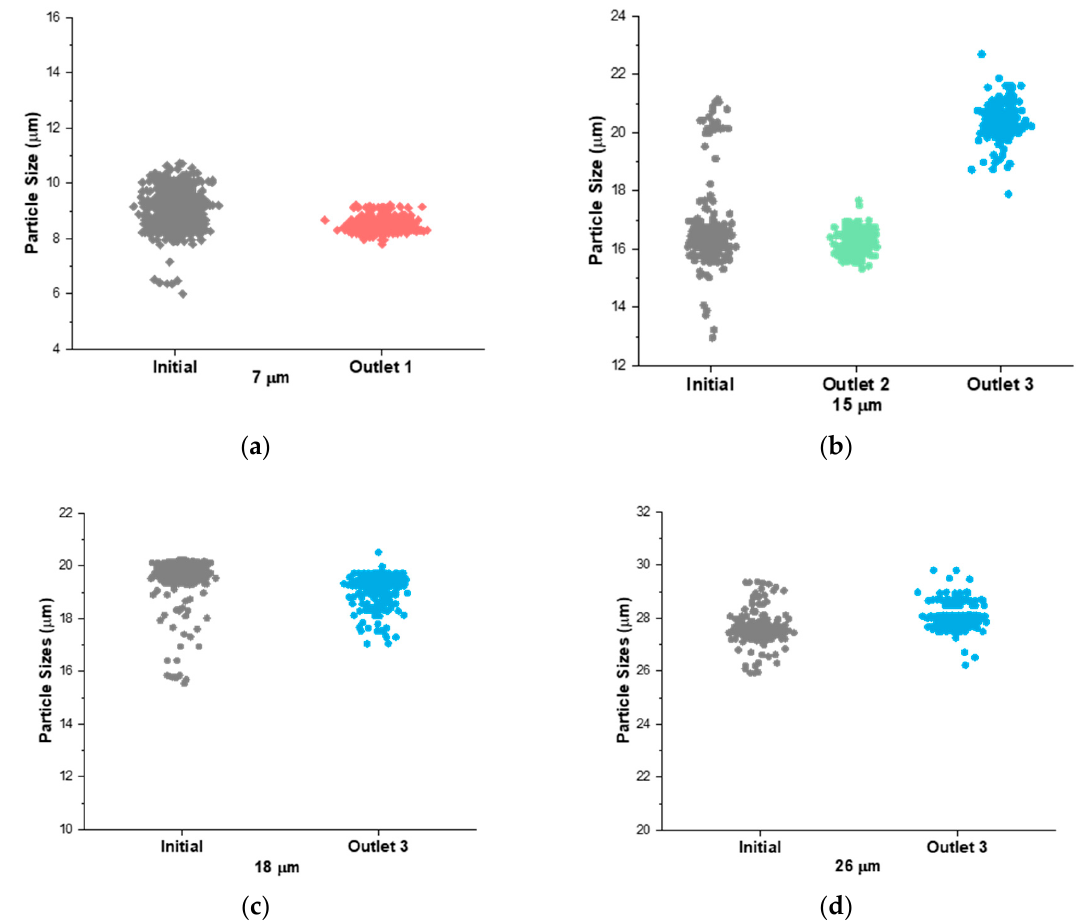
Figure 6. Single sized particles individually run through the device at 300 μ L·min − 1 , 1:4 ratio, 0.59 resistance ratio. ( a ) All 7.32 μ m particles went into outlet 1. ( b ) The 15.45 μ m particles split between outlet 2 and outlet 3 with minimal overlap. ( c ) All 18.7 μ m particles went into outlet 3. ( d ) All 26.3 μ m particles went into outlet 3.